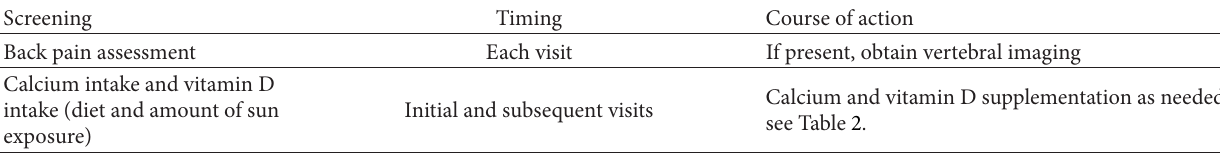
Table 1: Screening recommendations and course of action summary for children with DMD [26,